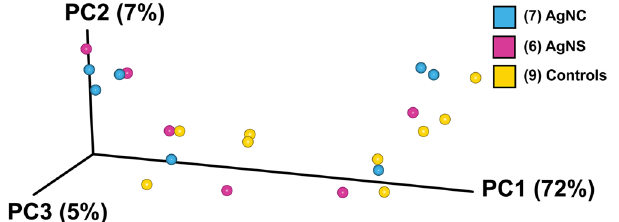
Figure 7. PCoA analysis of fecal microbiome data from AgNC, AgNS, and control groups. No clear distinctions are evident based on PCoA analysis. The PERMANOVA values for the three comparisons were: AgNC vs AgNS P = 0.18; AgNC vs Cont P = 0.50; P = AgNS vs Cont P =